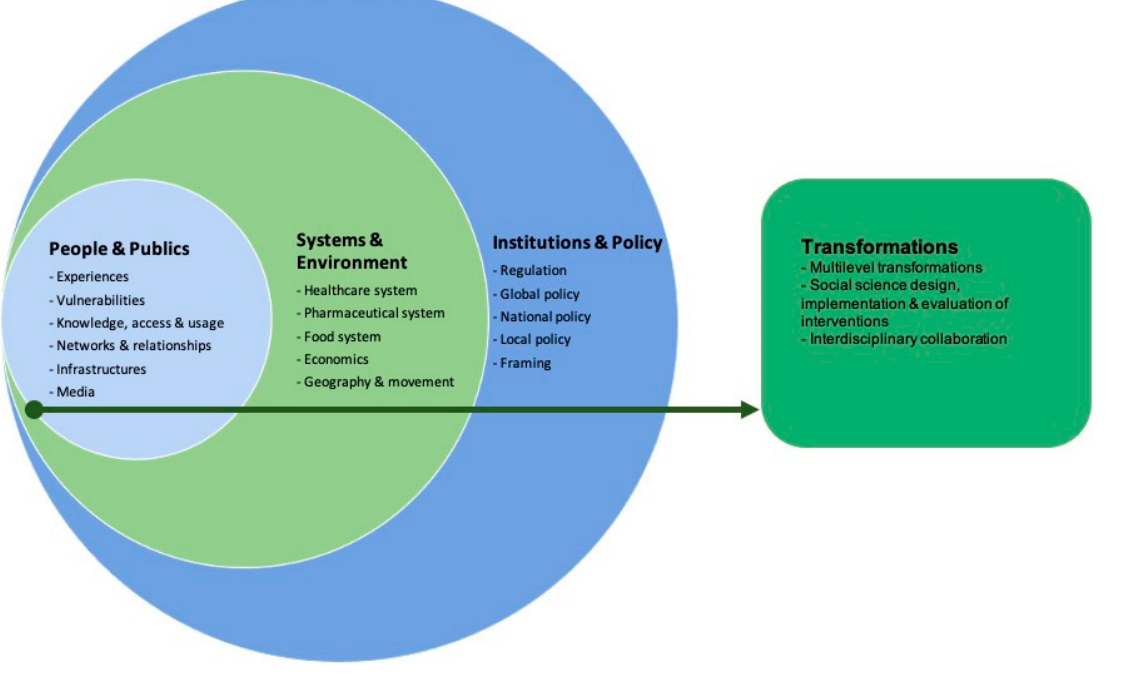
Figure 1. SPECIAL SOC AMR Framework.